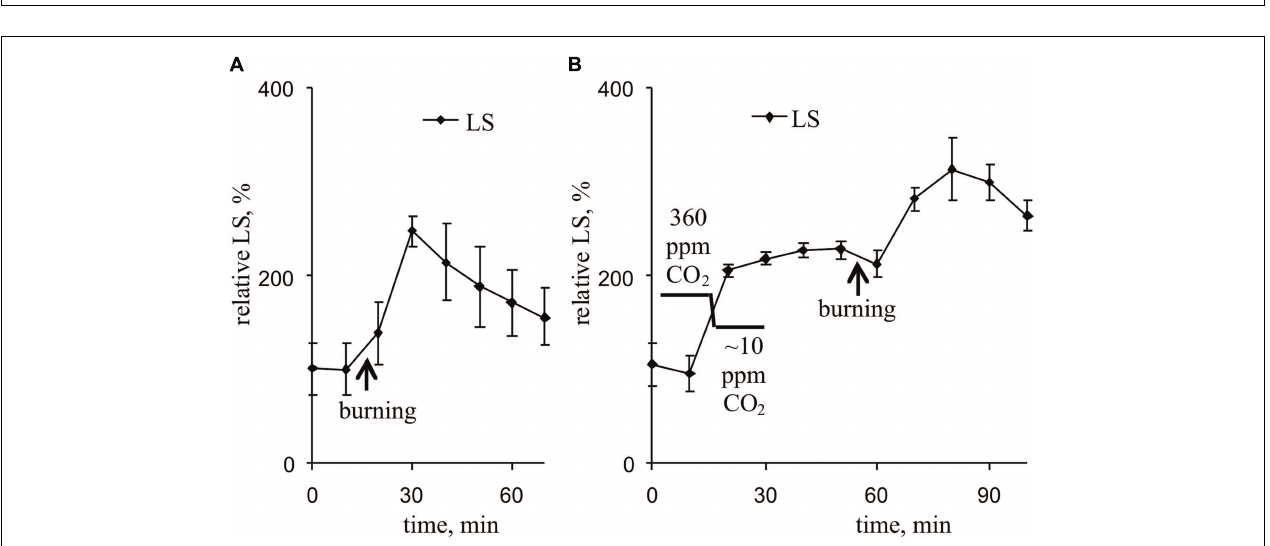
FIGURE 6 | Changes in the relative ECS pmf , ECS (cid:49)(cid:57) , and ECS (cid:49) pH induced by VP at 360 ppm (A) and approximately 10 ppm (B) CO 2 ( n = 6–8). The mean ECS pmf magnitudes prior to VP or a decrease in the CO 2 were assumed to be 100%. Points were measured every 600 s (450 s light, 150 s dark). The VP was induced by burning the first mature leaf (arrow).